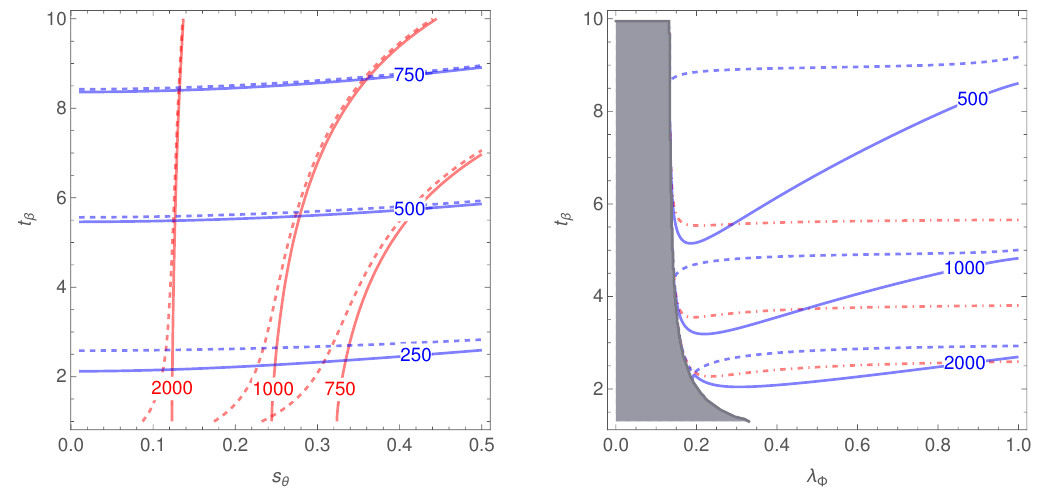
Figure 1 . Left panel: model I spectrum. The blue (red) solid contours show the mass of the heavier CP-even state, H , in GeV for (cid:12)xed m 2 mass of the pseudoscalar (cid:5) 5 for the same scenarios. Right panel: model II spectrum. The solid (dashed) blue lines show the mass contours (500 GeV, 1000 GeV, 2000 GeV) of m h mass of the heavy pion triplet follows closely the contours of m h clarity. The dot-dashed red lines show the same mass contours for the non-pGB mass eigenstate of the two mixing pseudoscalar states, (cid:5) 5 and S I . We have (cid:12)xed s (cid:18) = 0 : 1.